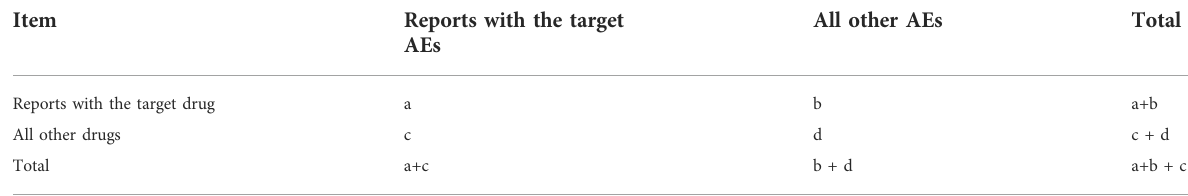
TABLE 1 Ratio imbalance measurement algorithm.